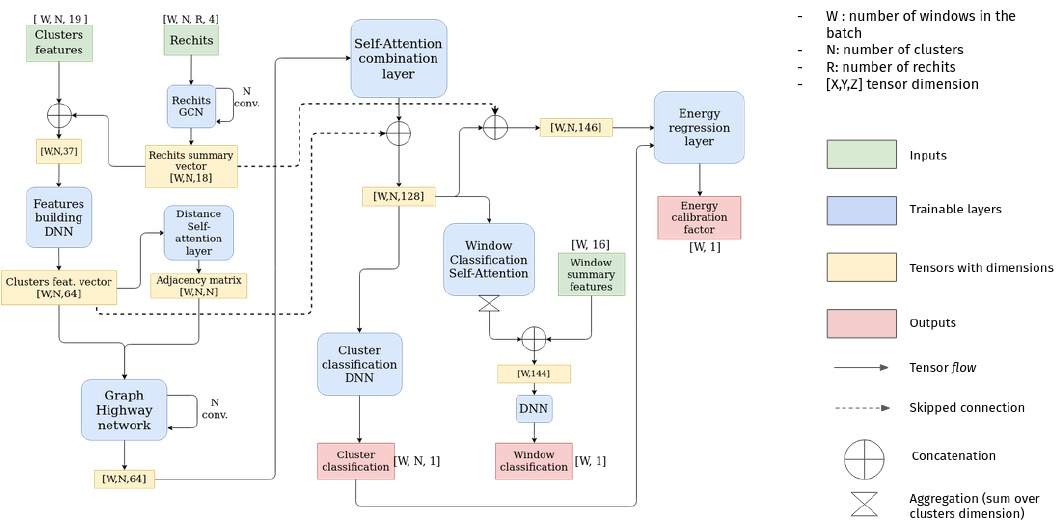
Figure 1. DeepSC model architecture. The input to the network consists of selected features and rechits of the clusters that fall into a predefined geometrical window. Using dense layers, the latent features are extracted from the initial input; they are processed and combined together using different types of graph architectures: Graph Convolutional Network (GCN) and Graph Highway Network (GHN). Self-attention layers are used as well, to help the network with focusing on the most important features/inputs. The final outputs are the following: information on whether each of the clusters belongs to the SuperCluster (cluster classification), the type of the particle from which the SuperCluster originated (window classification), and energy correction (energy calibration